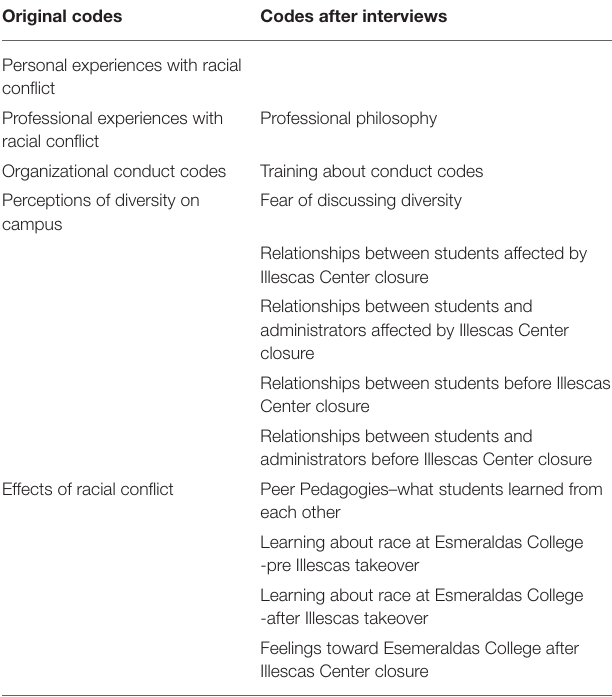
TABLE 3 | Sample of Codes. Original